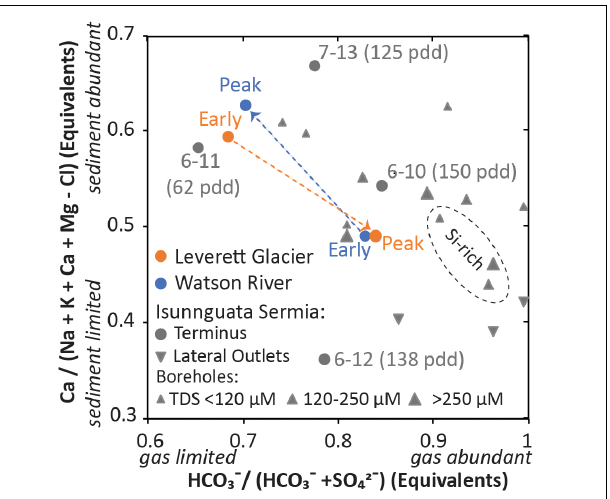
FIGURE 3 | Data from Greenland. Data from Leverett Glacier, Watson River, 6–11 and 7–13 represent multi-sample averages. Labels on Isunnguata Sermia terminus samples indicate month and year of collection and the number of positive degree days in the melt season to date. In the boreholes labeled Si-rich, the Ca likely comes from stoichiometric weathering of silicate minerals rather than calcite, and are thus likely more sediment supply limited than the y-axis metric